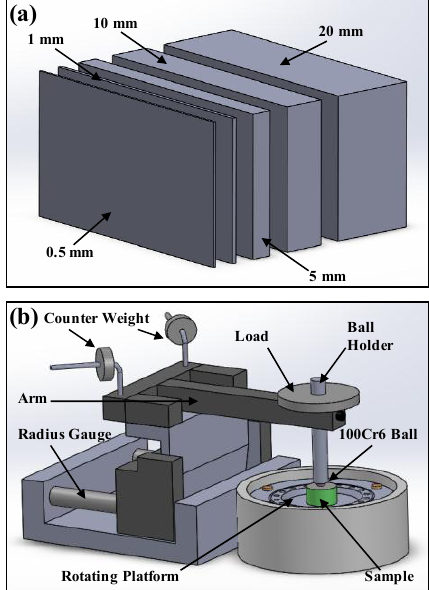
Figure 3. ( a ) Schematic of EBM-built Ti64 samples with thicknesses of 0.5, 1, 5, 10, and 20 mm. ( b ) Schematic configuration of the ball-on-disc micro-tribometer.